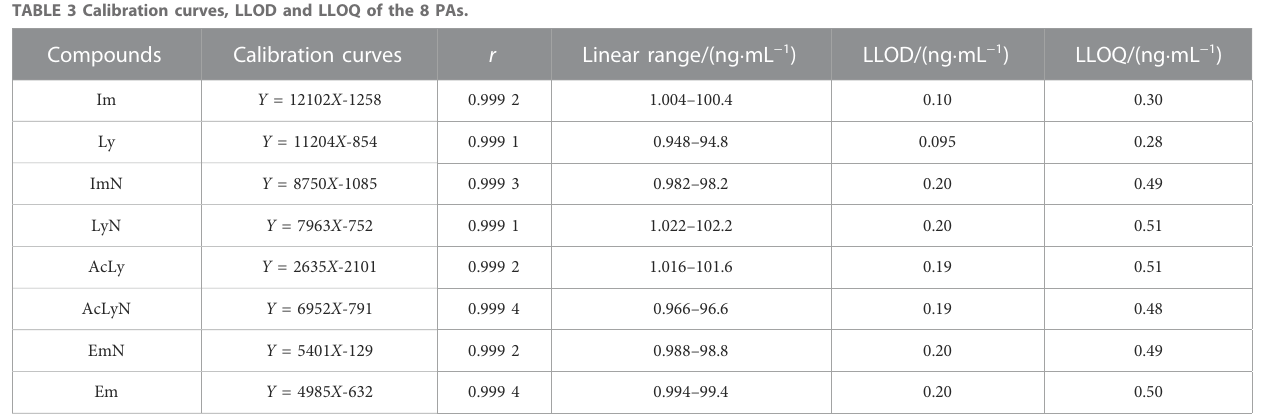
separated by chromatography. Also, the mobile phase proportion and fl ow rate were adjusted to achieve good separation. The best mass spectrum parameters, cone voltage, and collision voltage were obtained by comparing the ionization intensity of the reference solution.